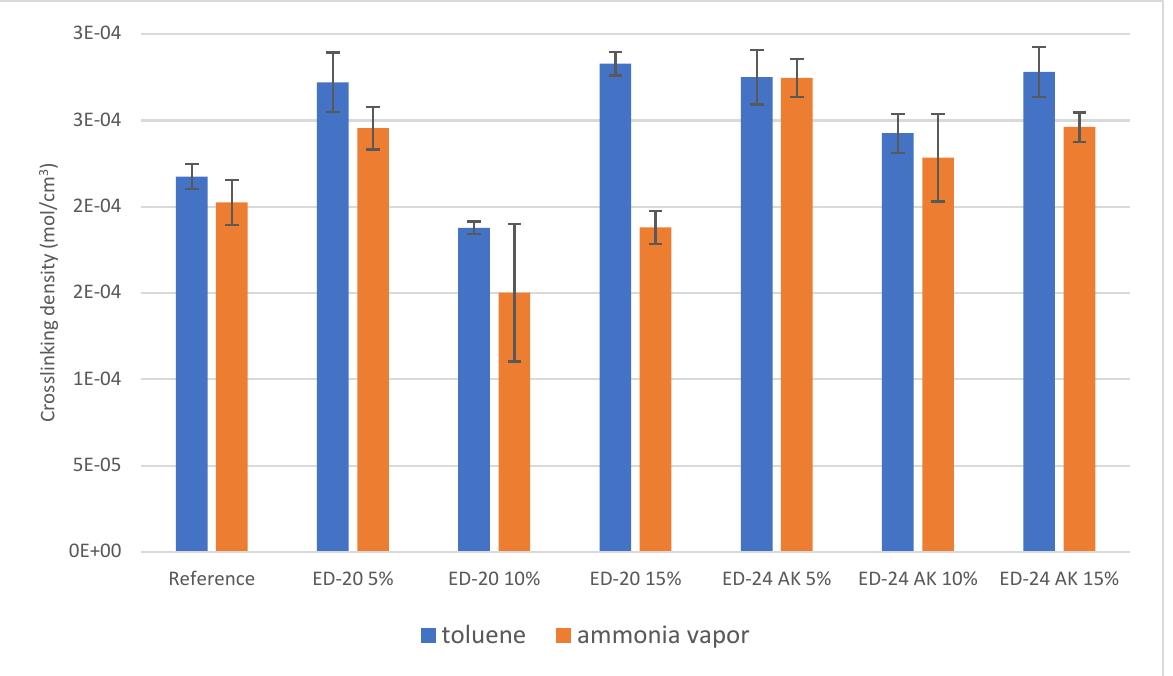
Figure 4. Influence of resin addition on the crosslink density of NBR (nitrile butadiene rubber) Figure 4. vulcanizates.